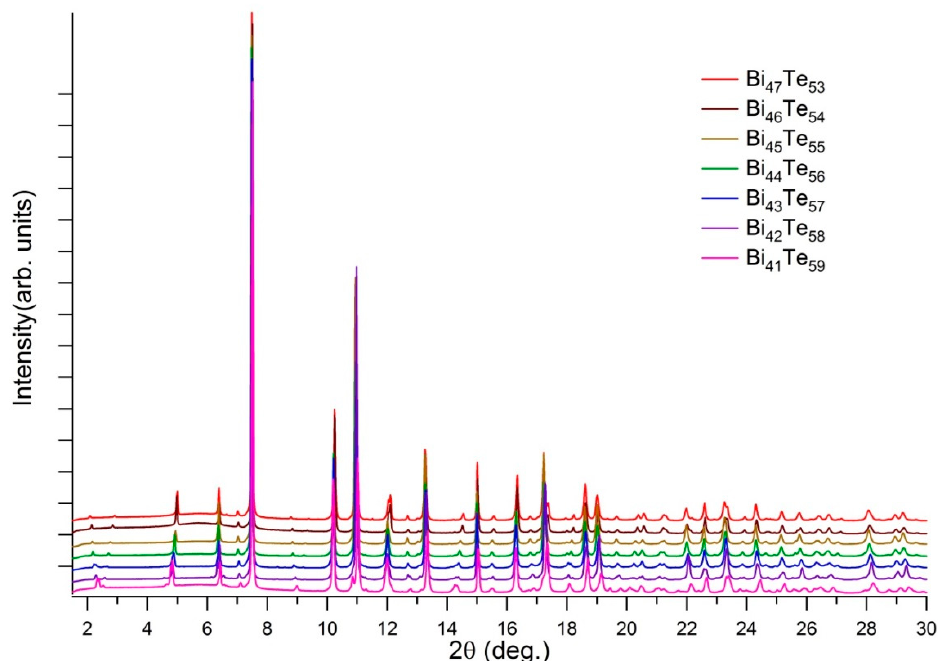
Figure 5. X-ray powder di ff raction profiles of Bi–Te specimens acquired at 300